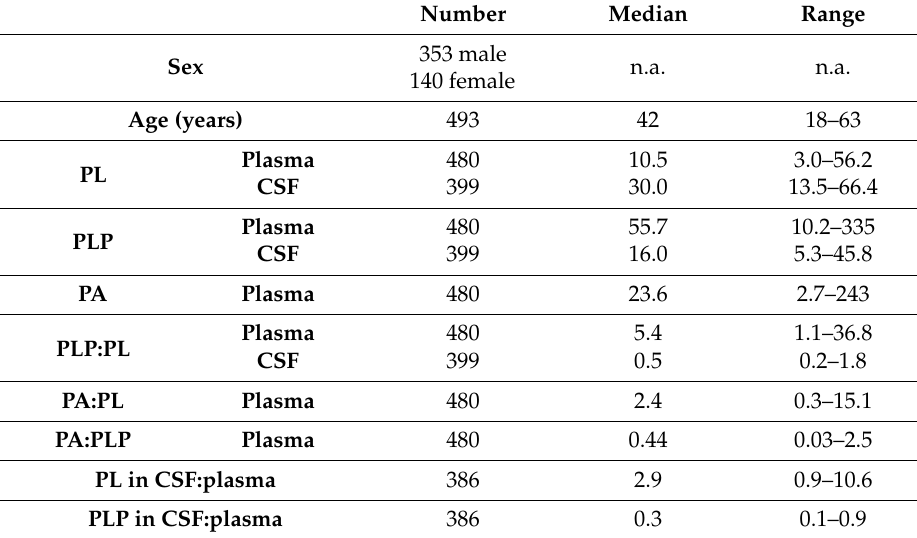
Table 1. Characteristics of the 493 genotyped subjects and their B6 vitamer (pyridoxal (PL), pyridoxal phosphate (PLP)) and pyridoxic acid (PA) concentrations (nmol/L) and ratios in and between cerebrospinal fluid (CSF) and